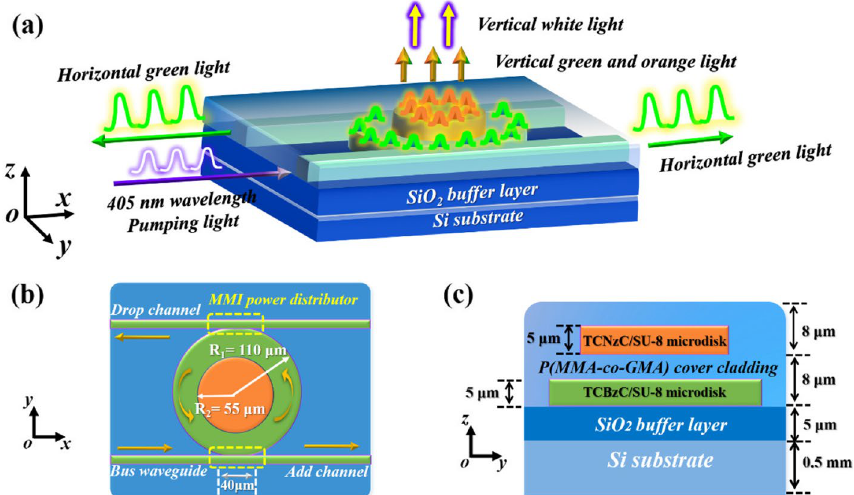
Fig. 9 a Schematic model of dual-microdisk 3D integrated on-chip optical sources; b structural parameters of the dual-microdisk waveguide devices in x – y profiles; c cross-sectional sizes of the top and bottom waveguide microdisks in y – z